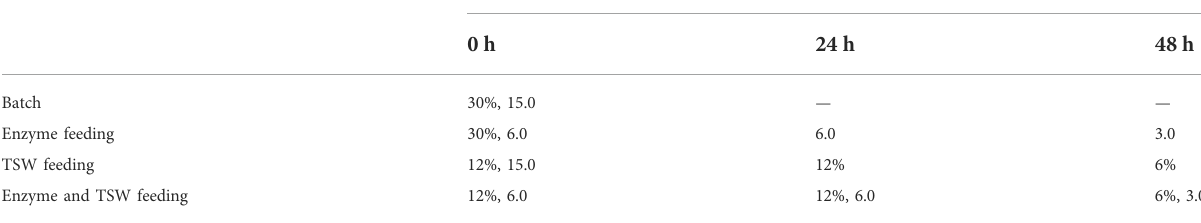
TABLE 1 Enzyme and TSW loadings for different feeding strategies in fed-batch SSCF with a feeding period of 48 h. Samples